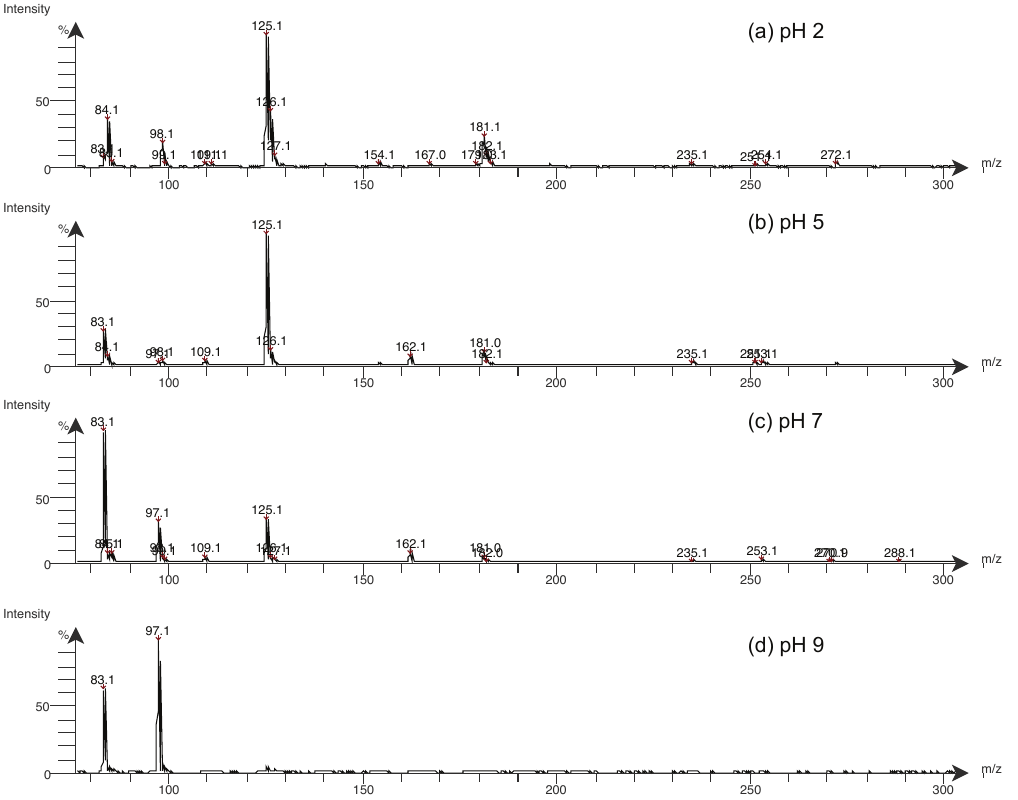
Figure 8. Atmospheric pressure chemical ionization (APCI) mass spectra for all four initial pH conditions in the reaction between 1.0M methylglyoxal and 1.0M ammonium sulfate in dried samples after 7 days. Intensity is set to 100% for the largest signal and does not correspond to concentration in the sample